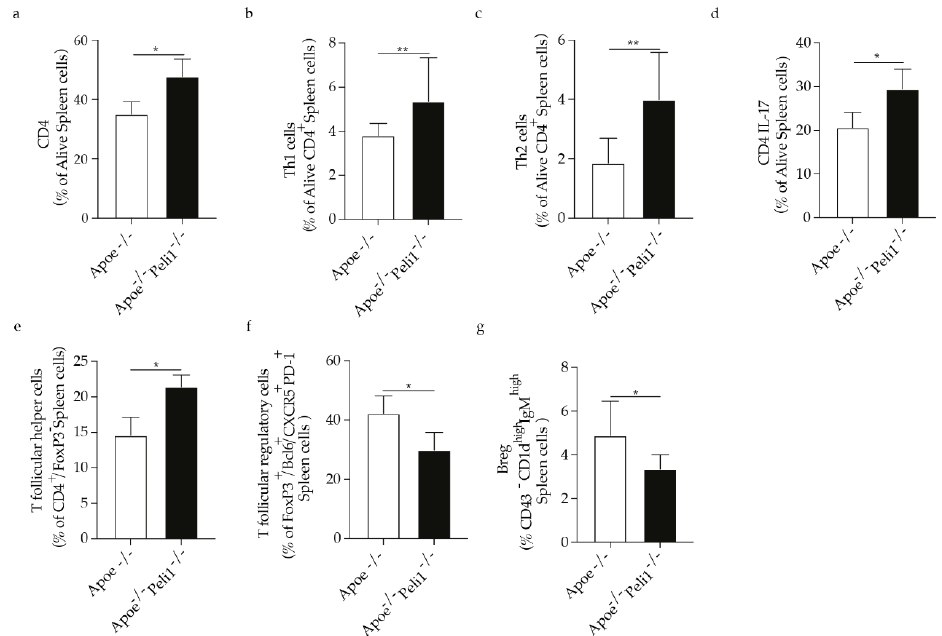
Figure 3. Bar graphs represent the quantification of the spleen (SP) ( a ) total CD4 cells; ( b ) Th1 cells; ( c ) Th2 cells; ( d ) CD4 IL-17 cells; ( e ) Follicular helper T cells; ( f ) Follicular regulatory T cells and ( g ) Breg cells in of Apoe − / − and Apoe − / − Peli1 − / − mice on HCD, n = 7–8/group, U-Mann Whiney, all data are presented as median with interquartile range with ± s.e.m with p ≤ 0.05 * and p ≤ 0.01 **.